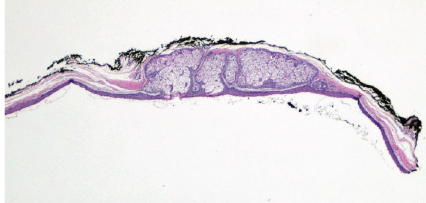
Figure 3: Sebaceous glands contiguous with the cyst wall. Hematoxylin-eosin, original magni fi cation ×